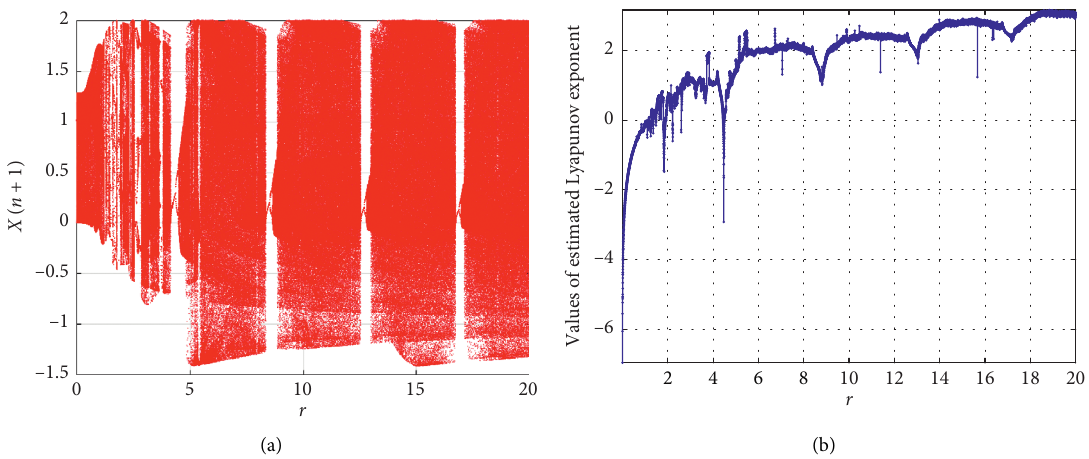
–2–1.5–1–0.500.511.52 Figure 8: Iteration and trajectory analyses of the third proposed chaotic map at x (b) r � 5.2, and (c) r � 12.0. Trajectory property at (d) r � 7.5, (e) r � 5.2, and (f) r � Figure 9: The bifurcation diagram (a) and Lyapunov exponent (b) for the fourth proposed map at x